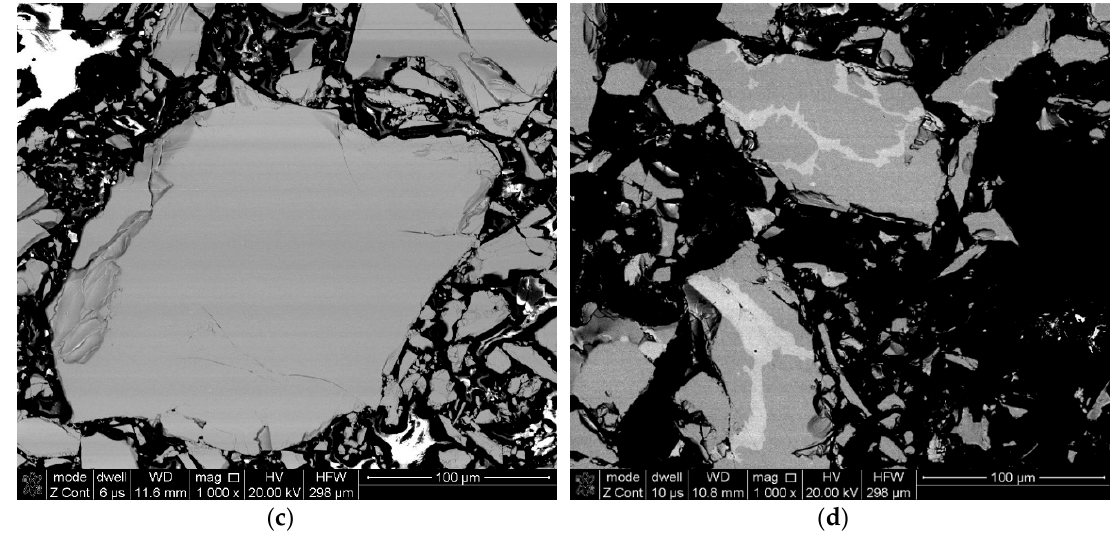
Figure 4. SEM images (BSE mode) of the cross-sections for the powder particles of: ( a ) LaNi 5 , ( b ) La 0.91 Ce 0.09 Ni 5 , ( c ) La 0.75 Ce 0.25 Ni 5 and ( d ) La 0.5 Ce 0.5 Ni 5.